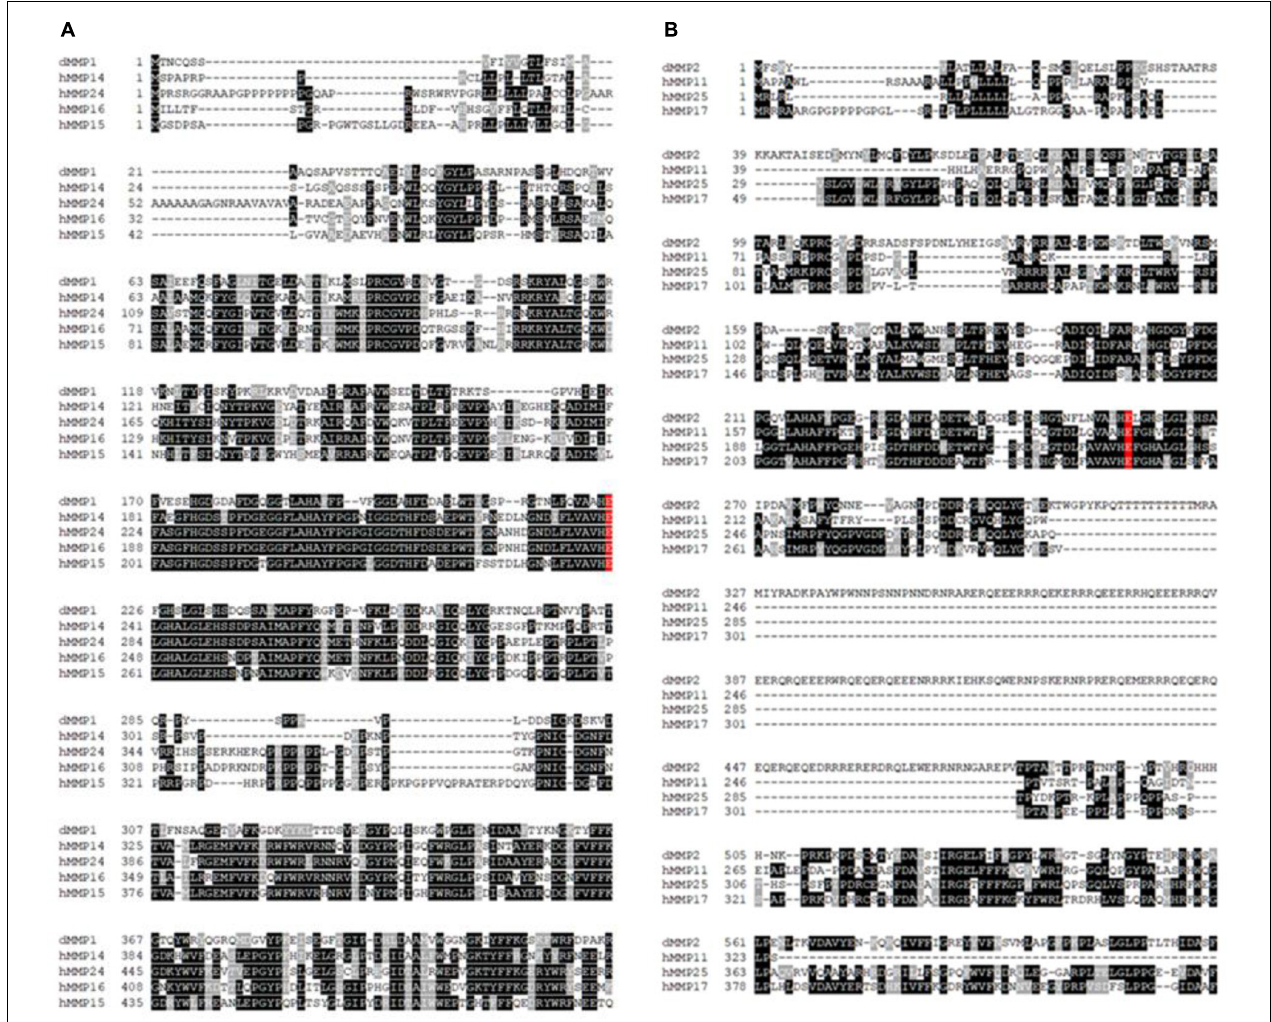
FIGURE 1 | Amino acid sequence alignments of (A) dMMP1 and (B) dMMP2 with human homologs. Identical amino acids are shown in black boxes and similar amino acids are highlighted in gray boxes. Gaps have been introduced to permit alignment. Conserved active sites are shaded in red.